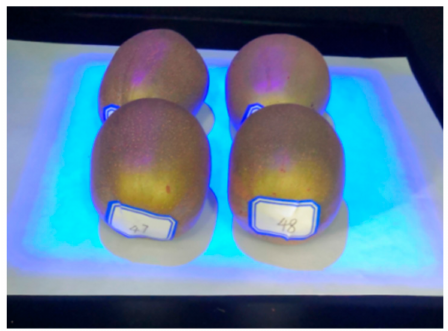
Figure 1. The kiwifruit samples.